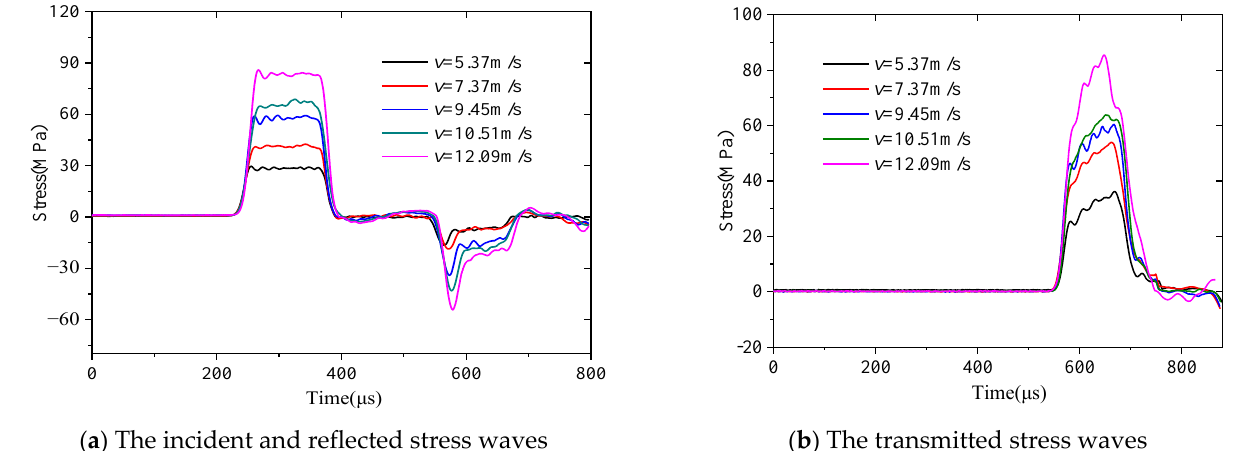
Figure 3. Waveforms of typical SHPB tests at different impact velocities.